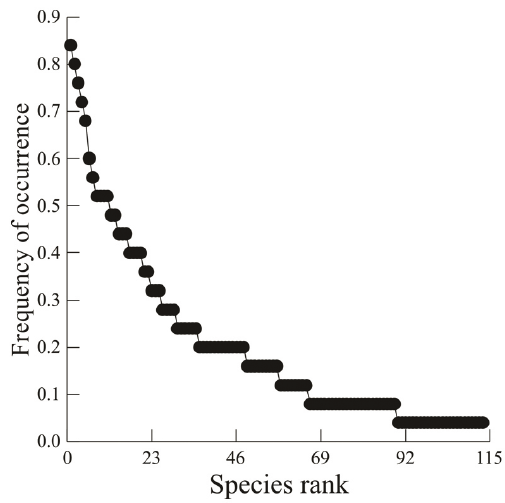
Figure 2. Frequency of occurrence of fish species sampled in streams of the Ivinhema River basin, Upper Paraná River, from 2001 to